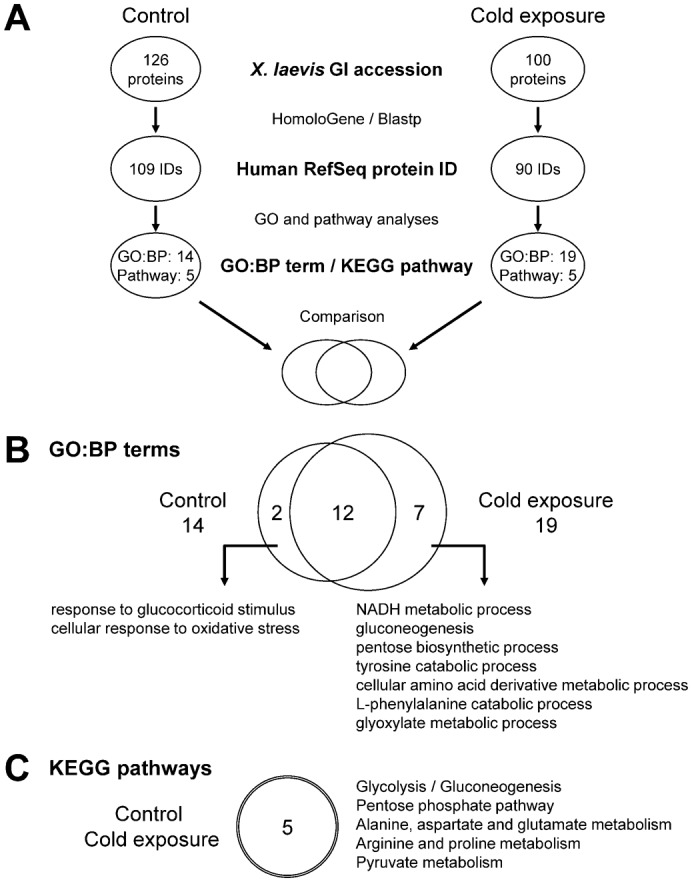
GO and pathway analyses of X. laevis liver proteomes.(A) Schematic view of the data processing procedure. The GI accessions of X. laevis proteins were converted to human RefSeq protein IDs by using NCBI HomoloGene and BLASTp, and then GO and pathway analyses were performed by using the DAVID program. FDR-corrected P values were defined by modified Fisher's exact test with the Benjamini and Hochberg FDR correction. The significantly identified GO:BP terms appearing deepest in the hierarchy and the significantly identified KEGG pathways are shown (FDR-corrected P<0.01). The details are explained in the materials and methods. (B,C) Comparison of enriched GO:BP terms (B) and KEGG pathways (C) in the list of proteins identified between the control and cold-exposure conditions.